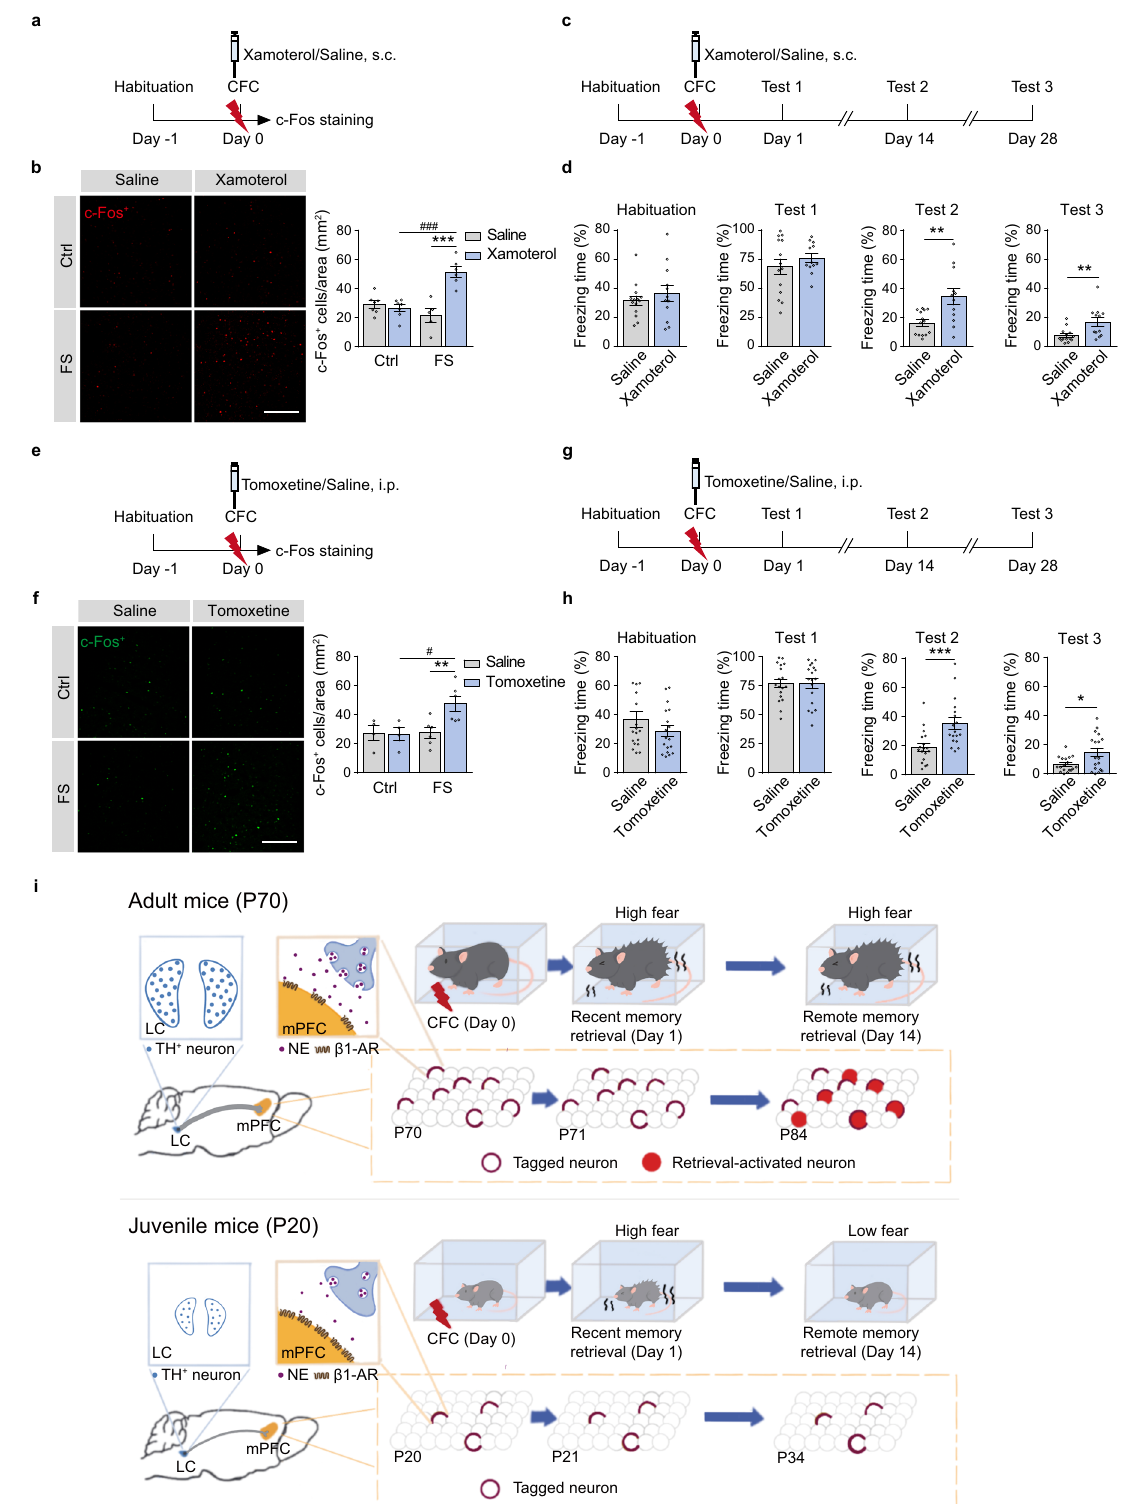
Fig. 7 | Activation of adrenergic signaling improves remote memory storage andearlyengramtagginginjuvenilemice.a , e Experimentalscheme.Xamoterol (3mg/kg, s.c.) or tomoxetine (3mg/kg, i.p.) was injected 30min before CFC. The juvenile mice were perfused 90min after CFC for c-Fos immunostaining. b , f Representative images and statisticalgraphs for c-Fos + cell counts in the mPFC ofjuvenilemice. c , g Experimentalscheme.Xamoterol(3mg/kg,s.c.)ortomoxetine